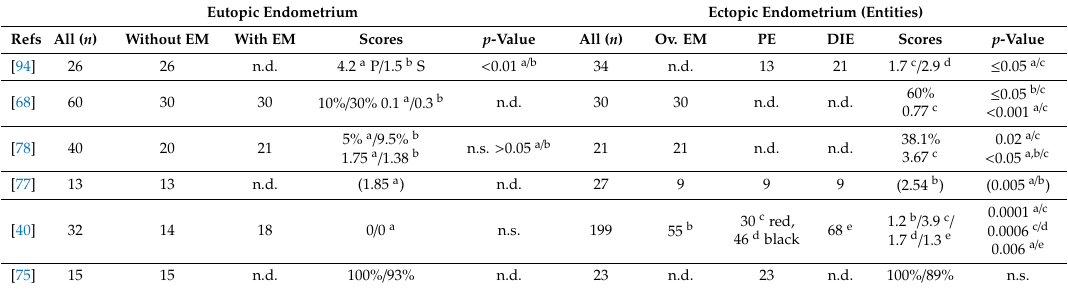
Table 7. Immunohistochemistry of N-cadherin in eutopic and ectopic endometrium. Eutopic Endometrium Ectopic Endometrium